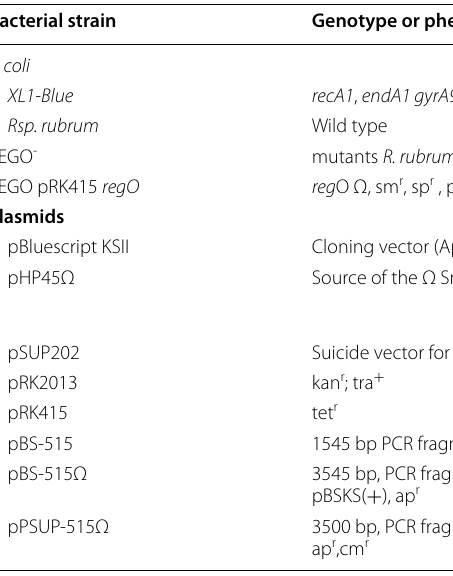
Table 1 Bacterial strains and plasmids